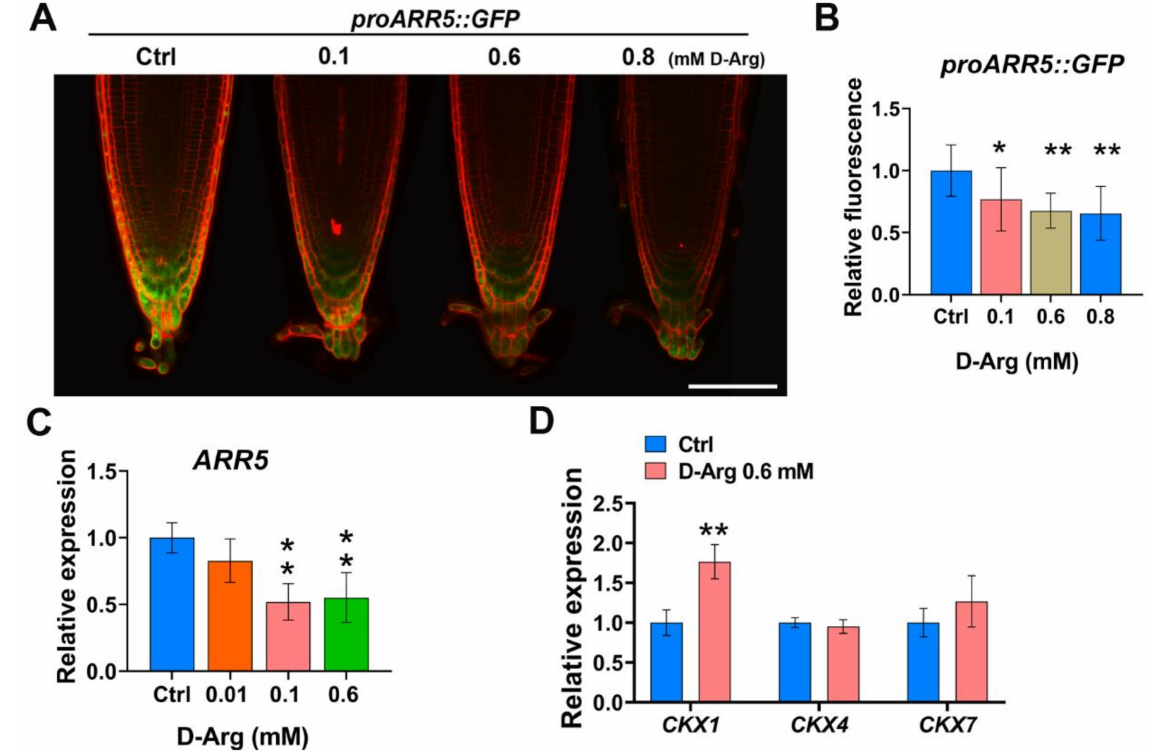
Figure 6. D-Arg treatment reduces the cytokinin response and increases CKX1 expression in the root meristem. Five-day-old seedlings at the same developmental stage were transferred to new media containing water (Ctrl) or D-Arg and treated for 3 days. ( A , B ) Confocal imaging indicates that increasing D-Arg gradually reduces cytokinin response proARR5::GFP and relative proARR5::GFP fluorescence. Scale bar = 100 µ m. ( C , D ) qPCR data indicate that D-Arg treatment modulates the relative expression of ARR5 and cytokinin oxidase ( CKX ) genes. Data shown are averages ± SD (n > 15). Asterisks indicate significant differences compared with the control (* p < 0.05, ** p < 0.01; Student’s t